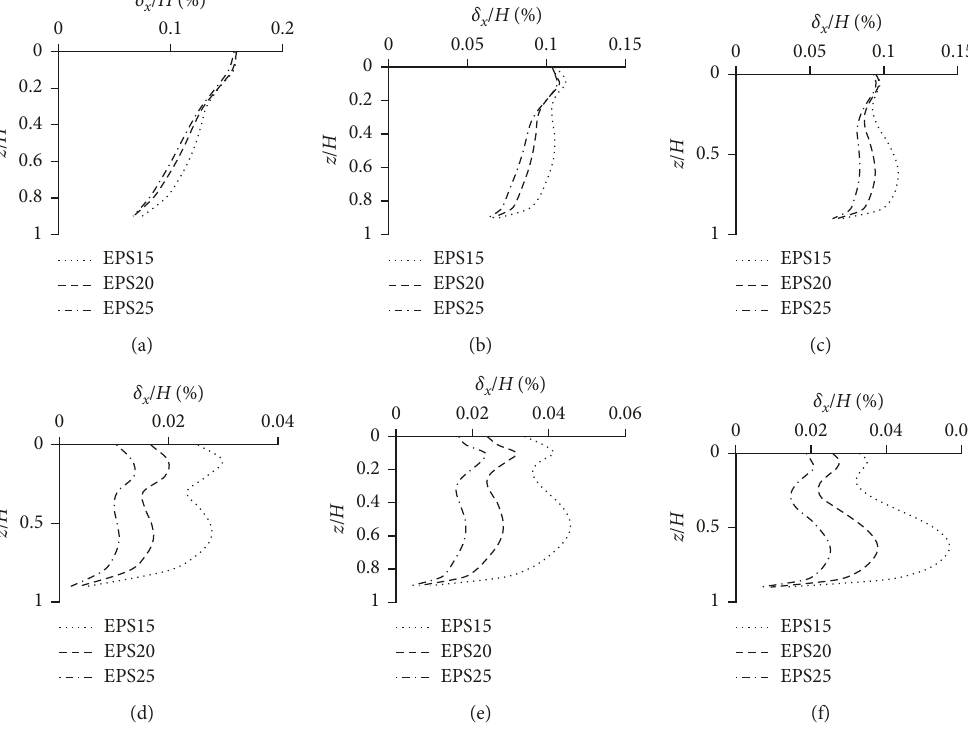
3m. (b) H 6m. (c) H 9m. (d) H 3m. (e) H 6m. (f) H 9m. (cid:31) (cid:31) (cid:31) (cid:31) (cid:31) (cid:31)